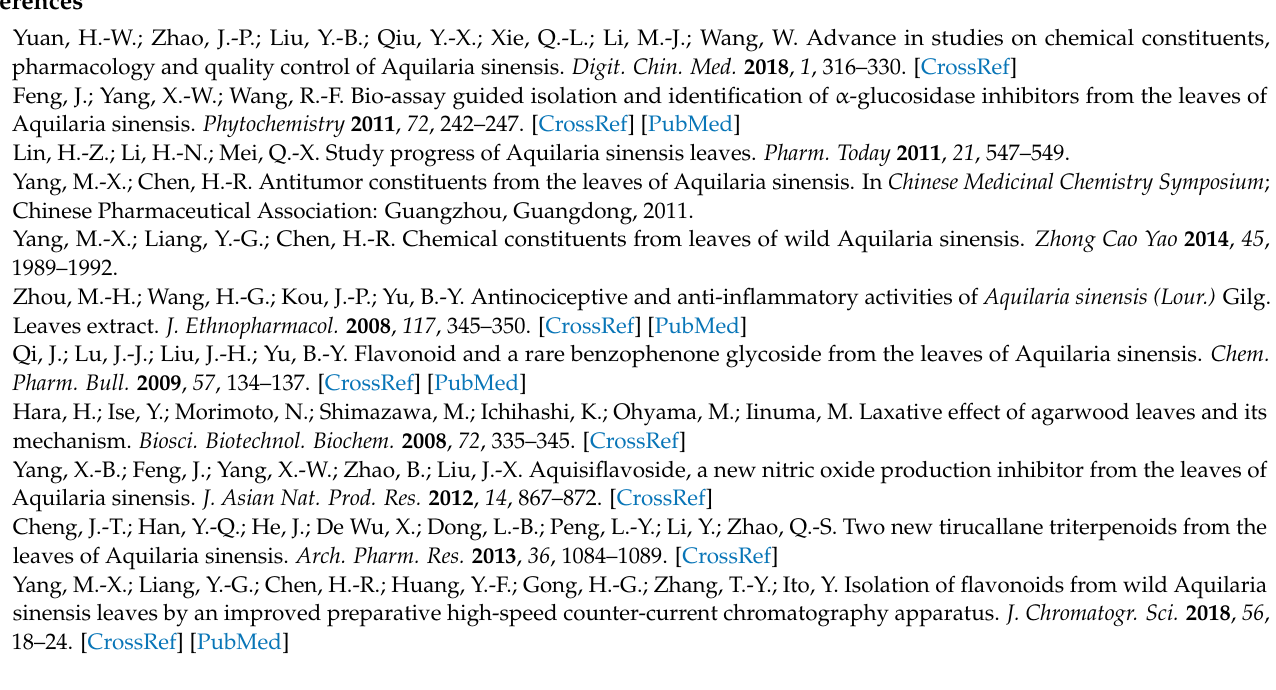
Supplementary Materials: The following are available online, Figure S1: NMR spectrum of AQ20; Figure S2. Effects of the five PA analogues on MMP-2 and MMP-9